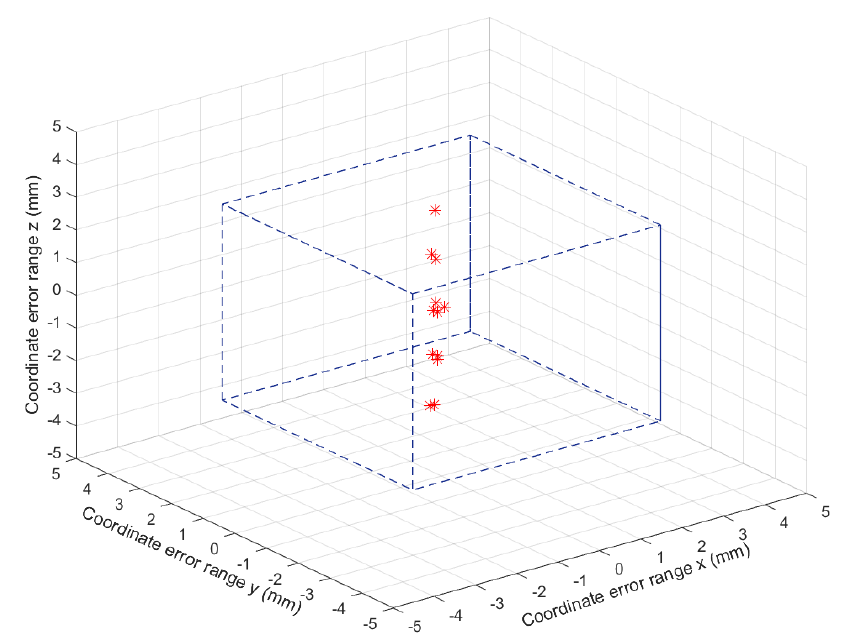
Figure 19. The 20 spatial coordinates fall within the coordinate error